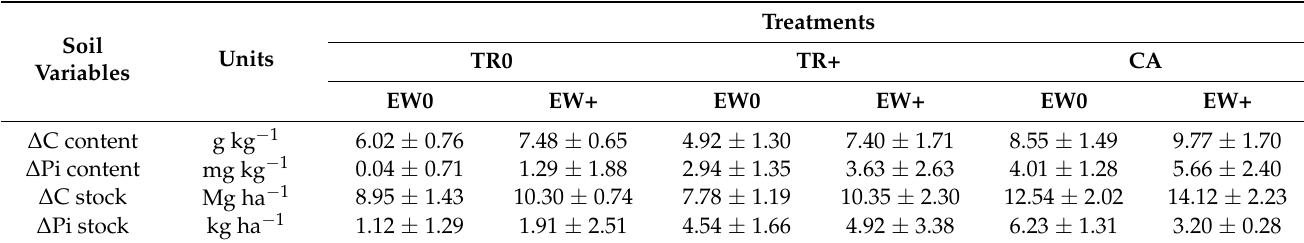
Table 4. Mean ± SE of changes of soil properties with time (2013 to 2016). Legend: see Table 2. Soil Units Variables ∆ C content